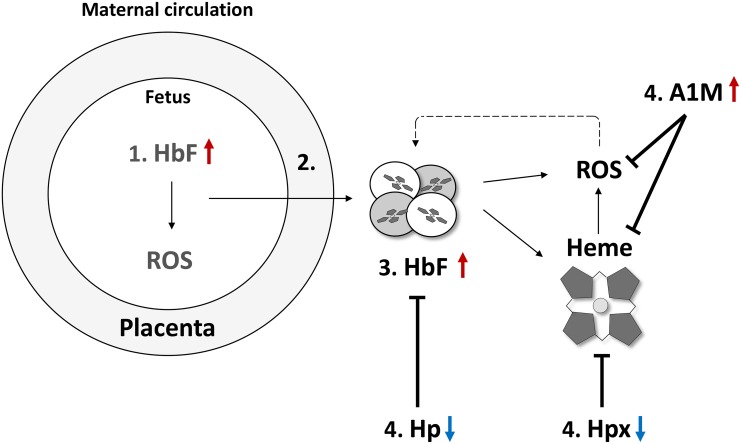
Schematic representation of the tentative chain of events involving HbF, Hp, Hpx, A1M and ROS and leading to PE.The figure shows a schematic placenta with impaired feto-maternal barrier function causing leakage of placenta factors. 1: Early events in the placenta induce an upregulation of the placenta HbF genes and protein and ROS. 2: Oxidative damage and leakage of the feto-maternal barrier results in 3: increased maternal plasma concentrations of HbF. Excess oxyHb undergoes auto-oxidation reactions resulting in free heme-groups and formation of ROS. 4: A complex network of scavenger proteins, composed of Hp, Hpx and A1M, binds, inhibits and eliminate HbF, heme and ROS. Cell-free HbF is bound by Hp and cleared by CD163 receptor-mediated uptake in monocytes and macrophage-cells. Free heme-groups are bound by Hpx and heme is cleared via the Hpx receptor CD91, preferably expressed on macrophages and hepatocytes. In this study, a highly significant decrease of both the Hp and Hpx was observed in maternal plasma of women with PE as compare to normal pregnancies. This indicated a prolonged presence of increased levels of both extracellular Hb and heme. Analysis of the plasma A1M levels in the present study displayed a significantly increase in women with PE as compared to normal pregnancies, most likely as a result of oxidative stress-induced up-regulation of the A1M gene expression.